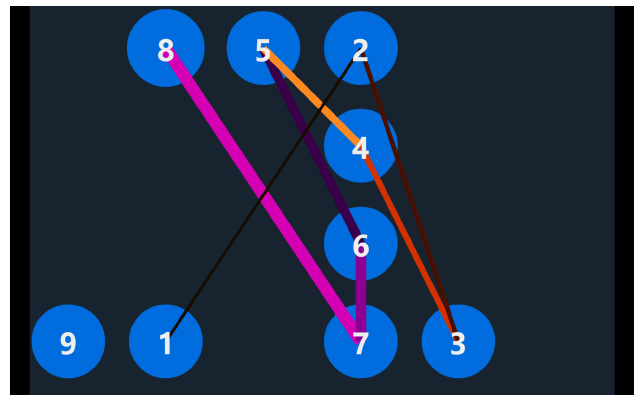
Fig. 4. Test based on Trail Making Test